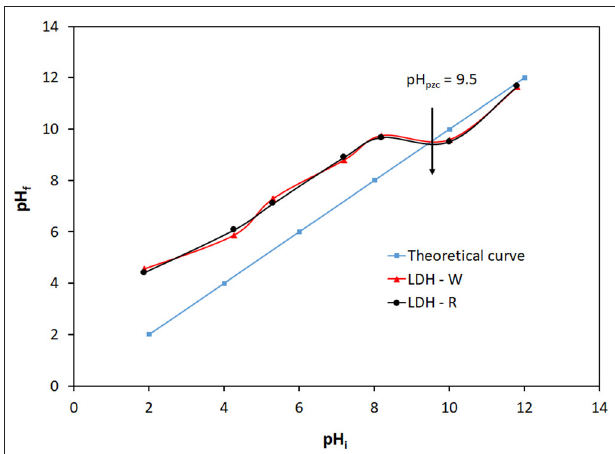
FIGURE 3 | Determination of pH pzc for the